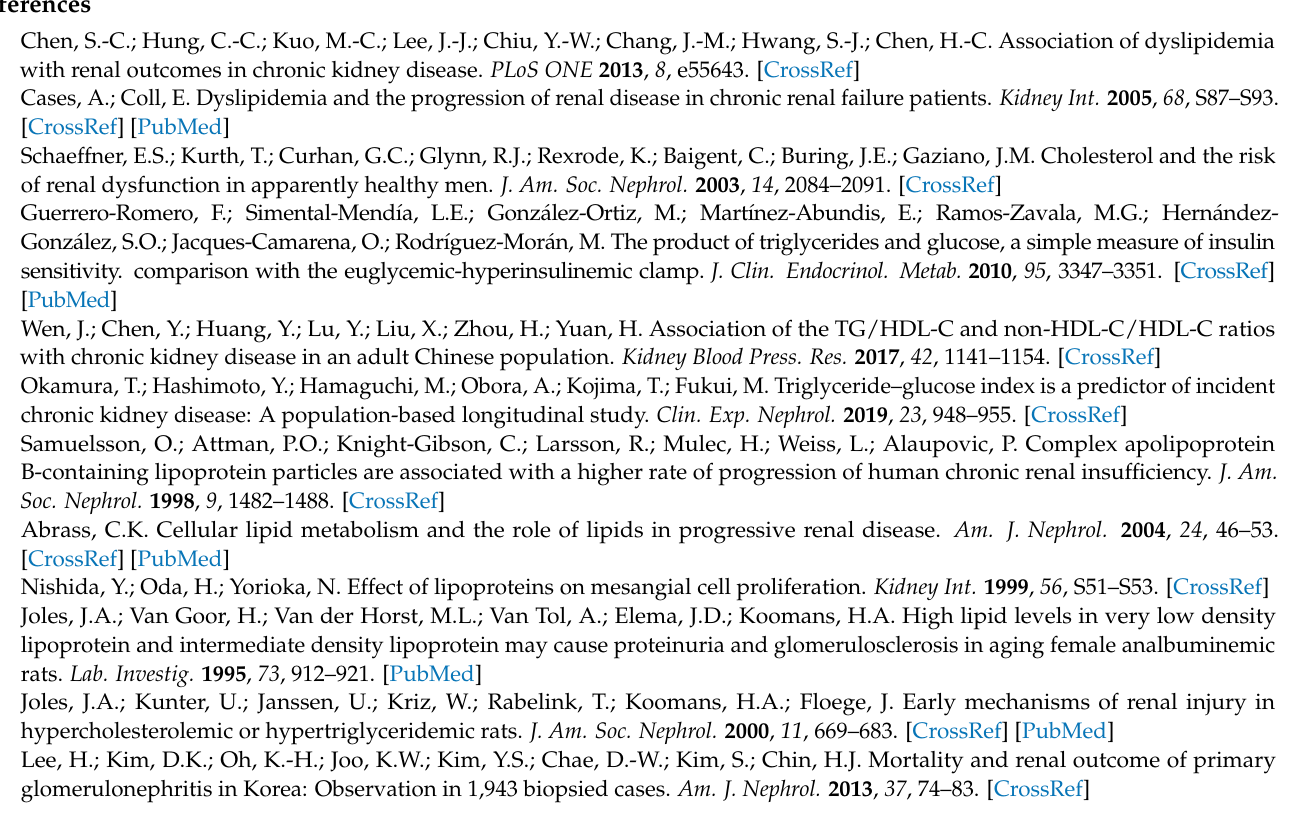
Figure S2: Pearson correlation graph for TGs and TyG with eGFR and Urine P/Cr. Table S1: The Oxford MEST classification of TG